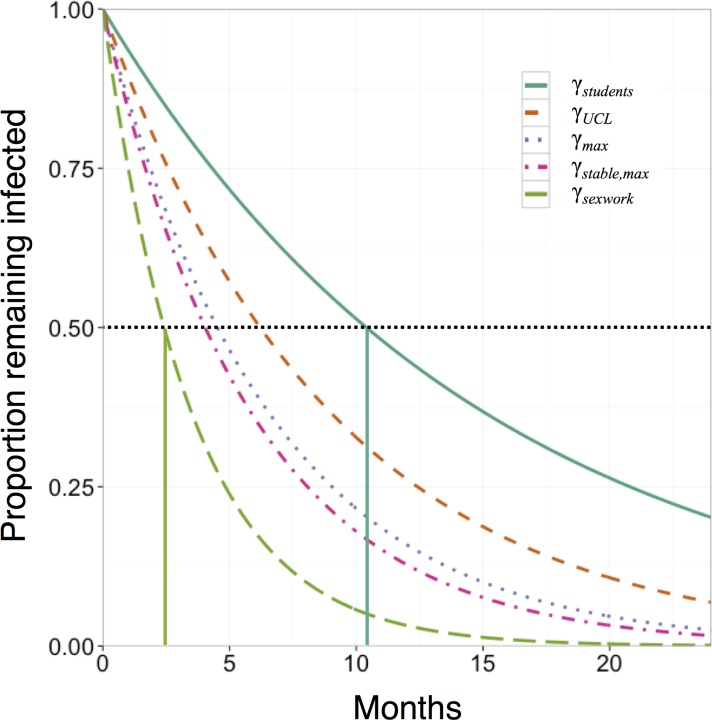
Duration of infection.Proportions of individuals remaining infected over time are shown for the various estimates of clearance rates, γstudents = 0.80p.a., γUCL = 1.34p.a., γmax = 1.84p.a., γstable,max = 2.06p.a. (all based on the London-student data), and γsexwork = 3.44p.a. (based on the Ugandan sex-worker data); vertical lines mark time points when, on average, half of the initially infected individuals will have cleared the infection, depending on the respective recovery rate.